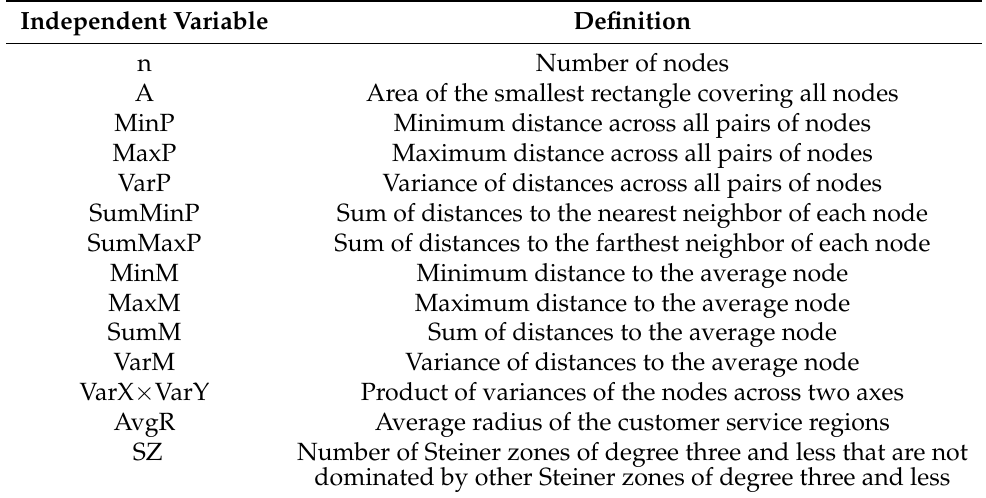
Table 1. Definitions of the independent variables for the regression model.